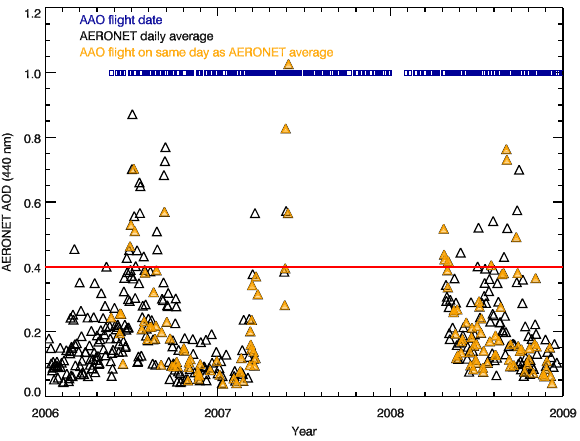
Fig. 1. Daily average of the AAO aircraft calculated aerosol opti- cal depth and of the AERONET optical depth (at 440nm) during the study period, and indicators of the days when AAO data are available.